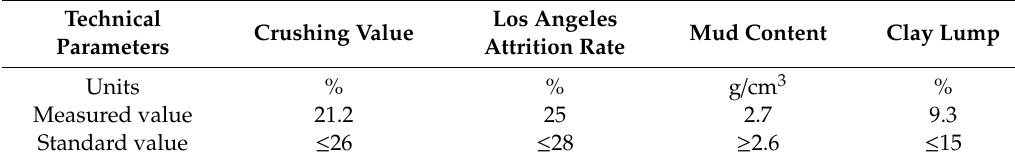
Table A2. Technical parameters of coarse aggregates.